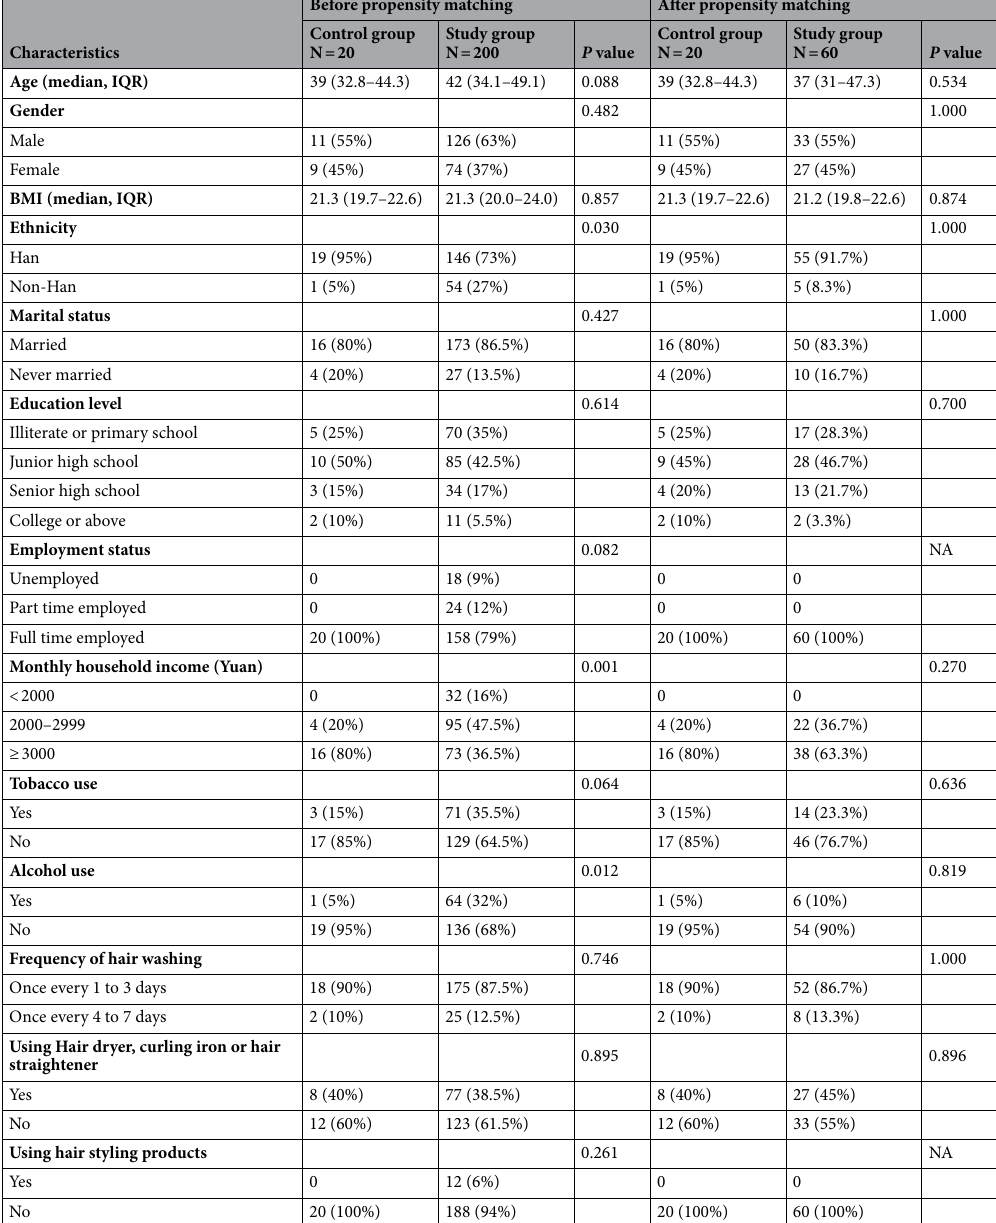
Table 1. Baseline characteristics before and after propensity matching in control and study groups. Data are presented as n(%) or median (25th–75th interquartile